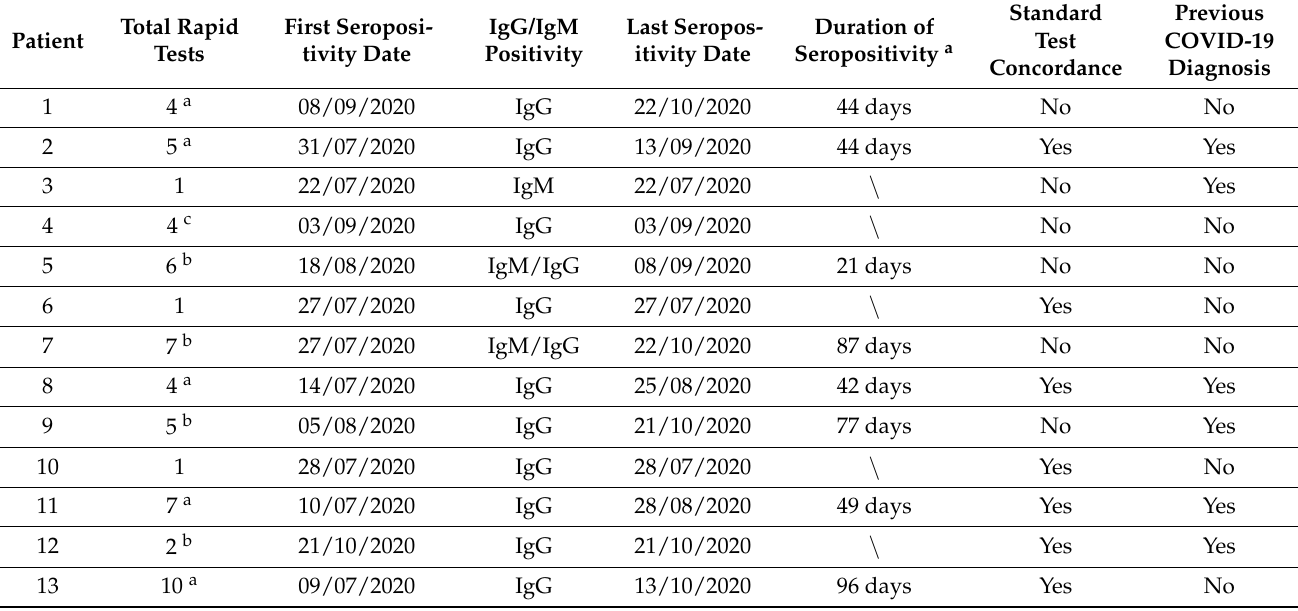
Table 3. Results over time of patients positive to the rapid serological